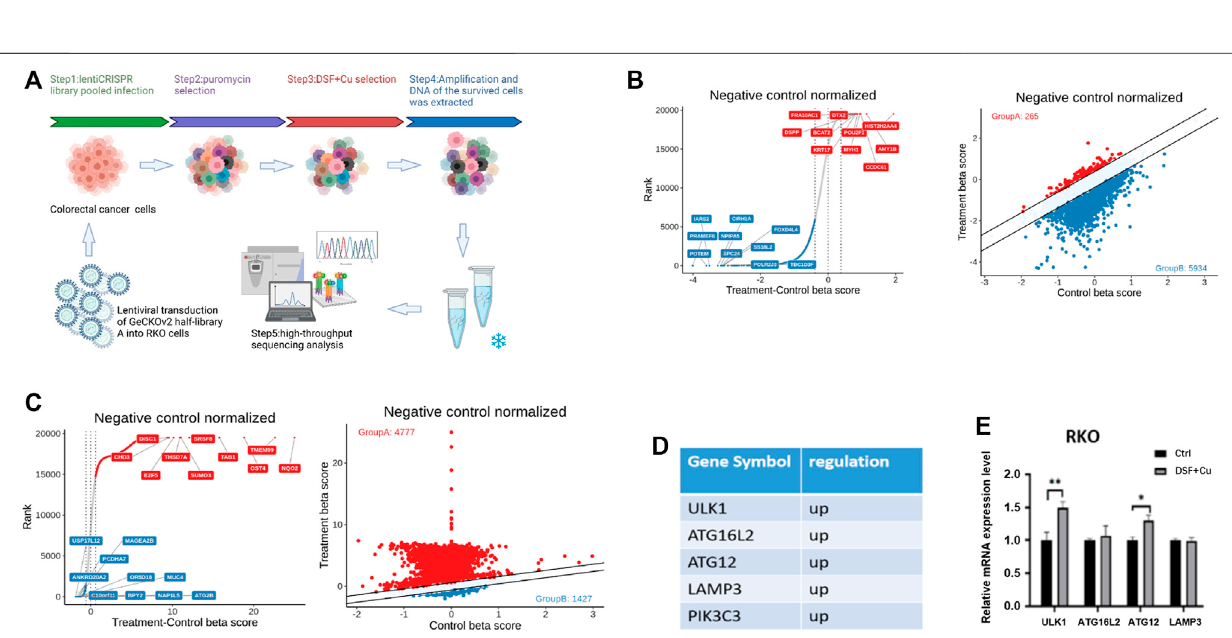
Frontiers in Pharmacology |